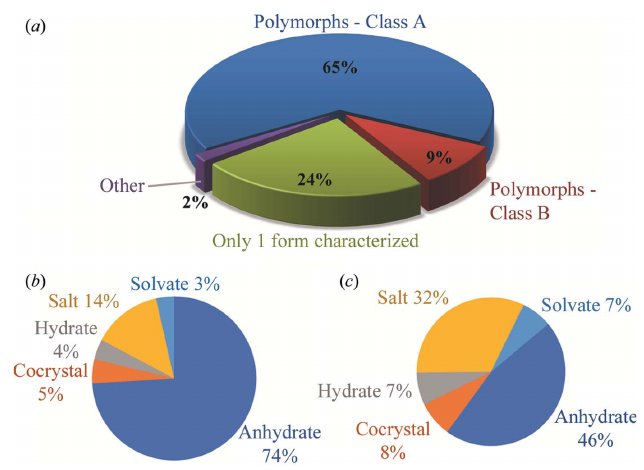
Figure 1 ( a ) A graphical breakdown of the entries flagged as polymorphs in the CSD. Panels ( b ) and ( c ) show further breakdown of the crystal types (anhydrate, non-hydrated solvate, salt, hydrate and cocrystal) for ( b ) polymorphs that can coexist and ( c ) polymorphs with known phase